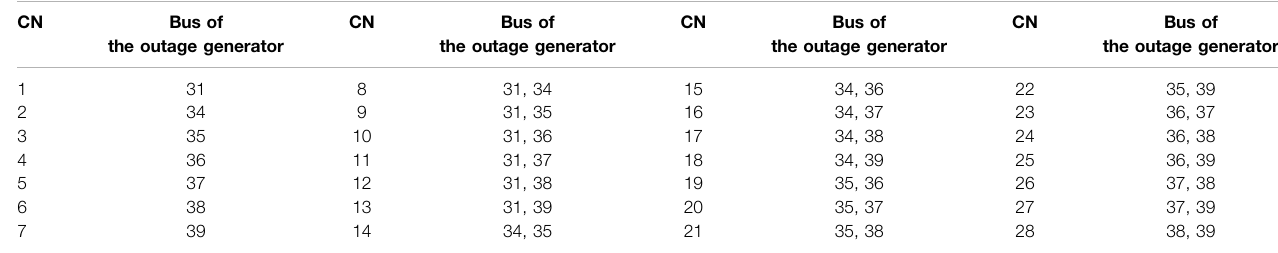
TABLE 3 | Information of contingency relevant to generator